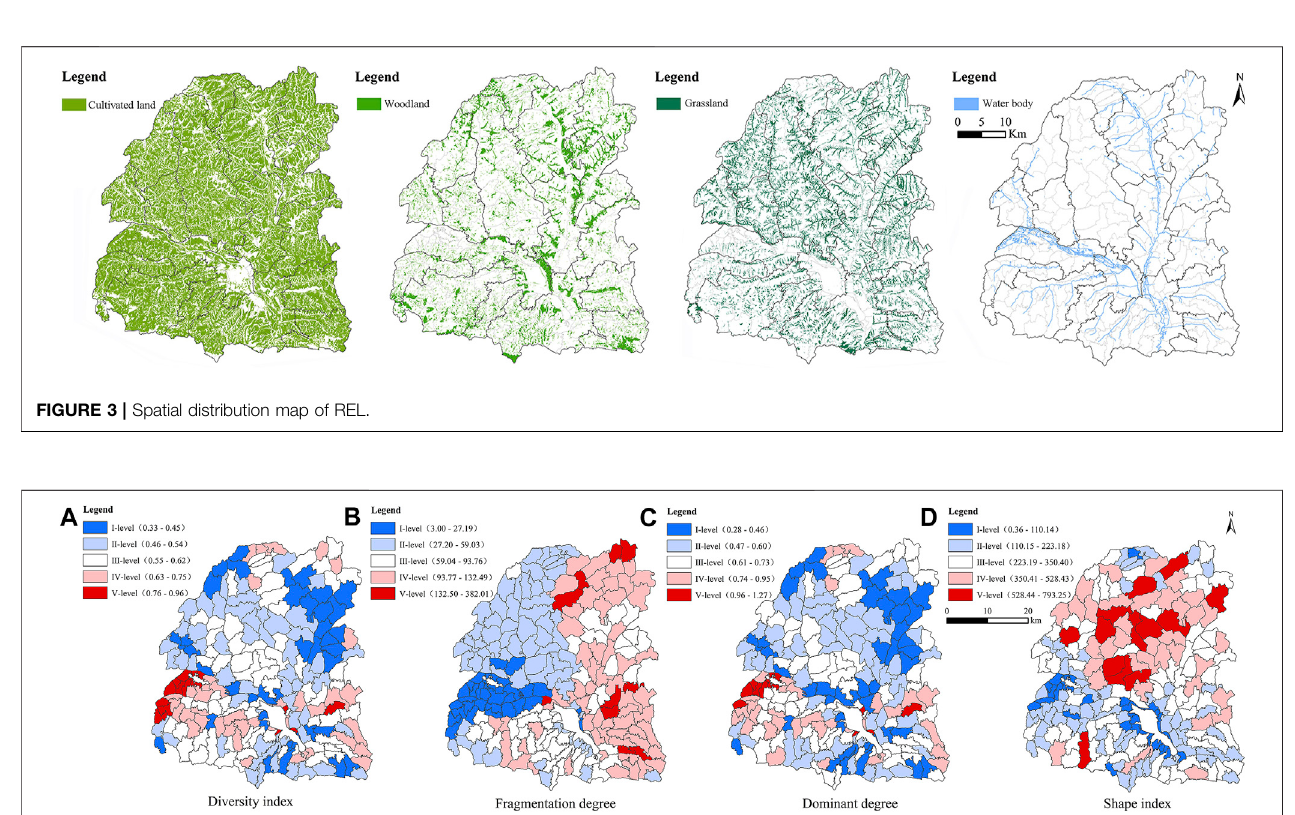
Frontiers in Environmental Science |